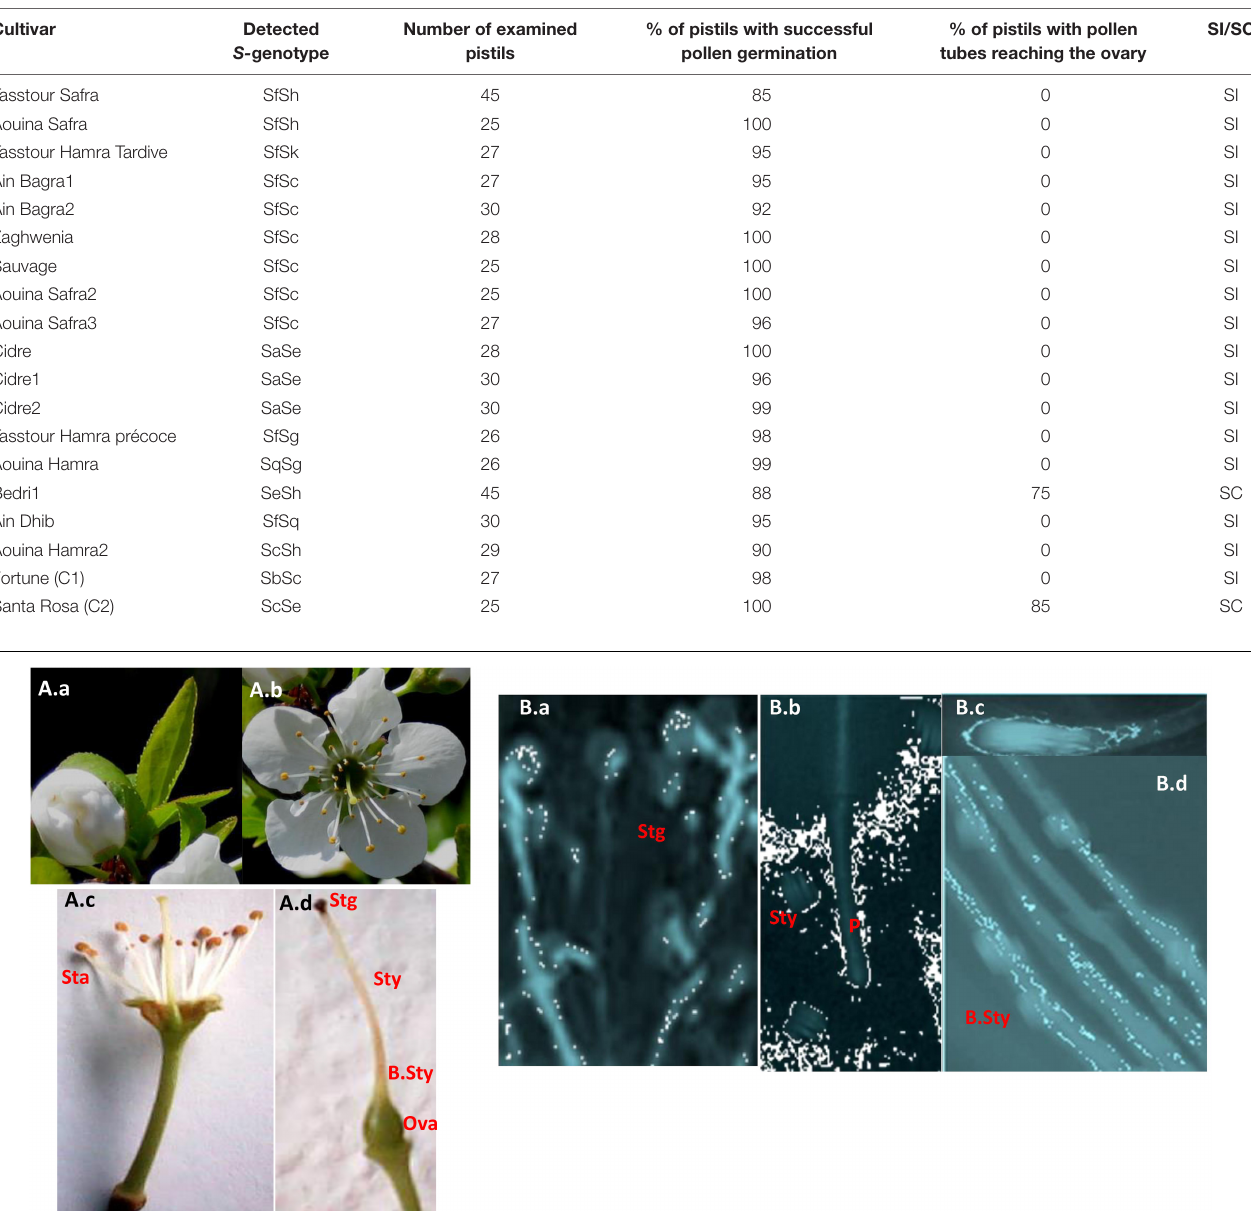
TABLE 3 | Self-(in)compatibility results in 17 Tunisian plums analyzed in this work. Cultivar Detected S- genotype